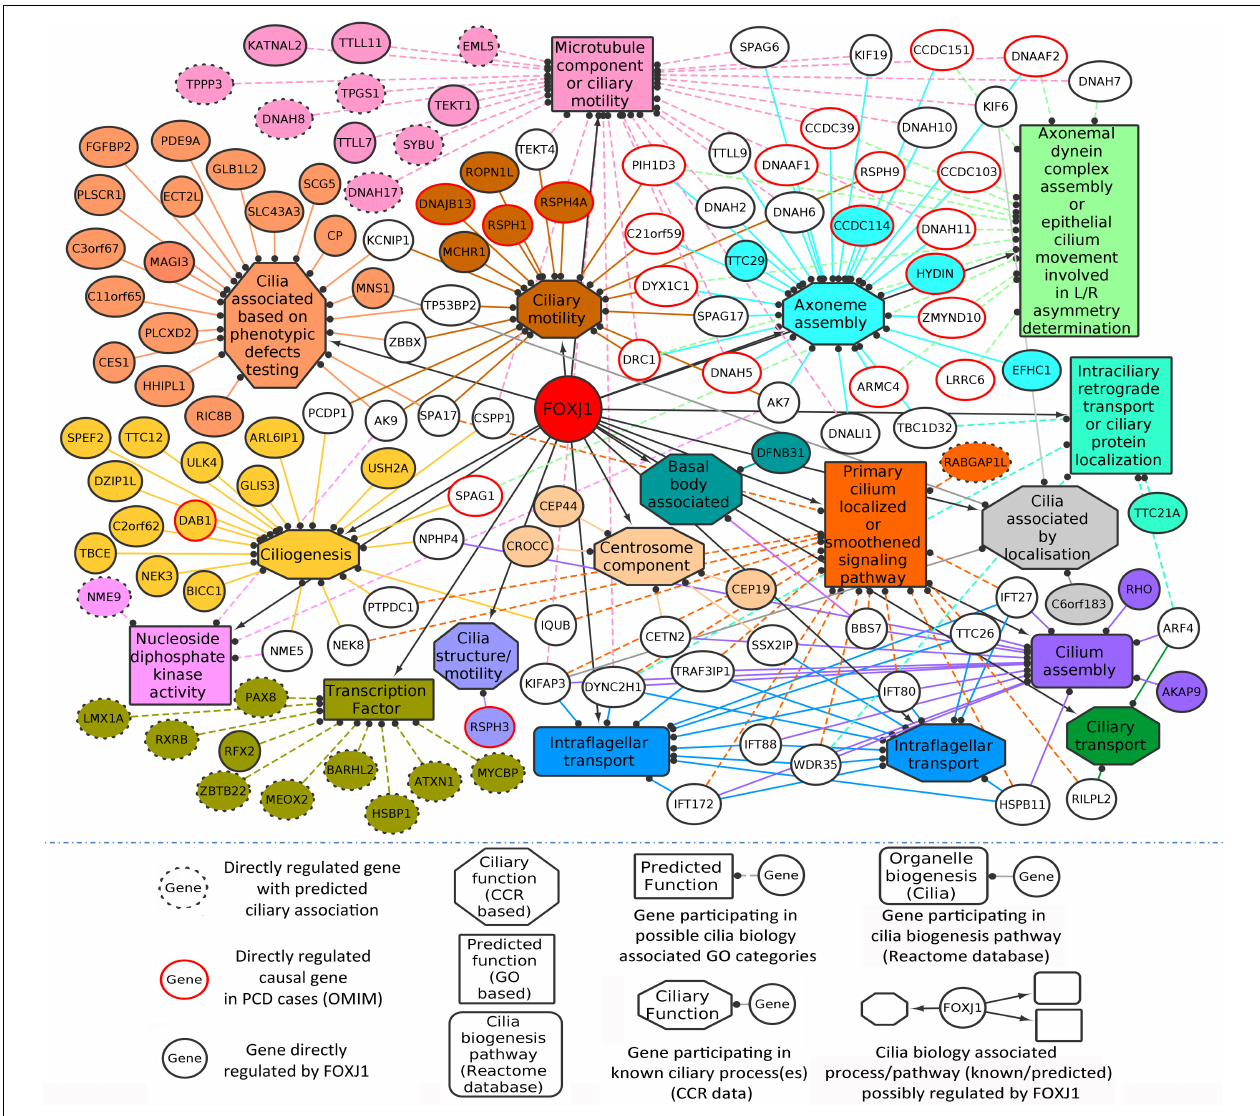
FIGURE 1 | Directly regulated genes in the predicted FOXJ1 gene regulatory network and possible ciliary processes mediated by them. FOXJ1 directly regulates genes that are involved in ciliary structure assembly and motility, as depicted here. Known ciliary associations were derived from the collated ciliary resource. Additionally, the probable roles of some genes predicted based on gene ontology analysis have also been included here. The genes and edges are color coded to indicate the processes the genes regulate or are involved in (genes associated with more than one process are not